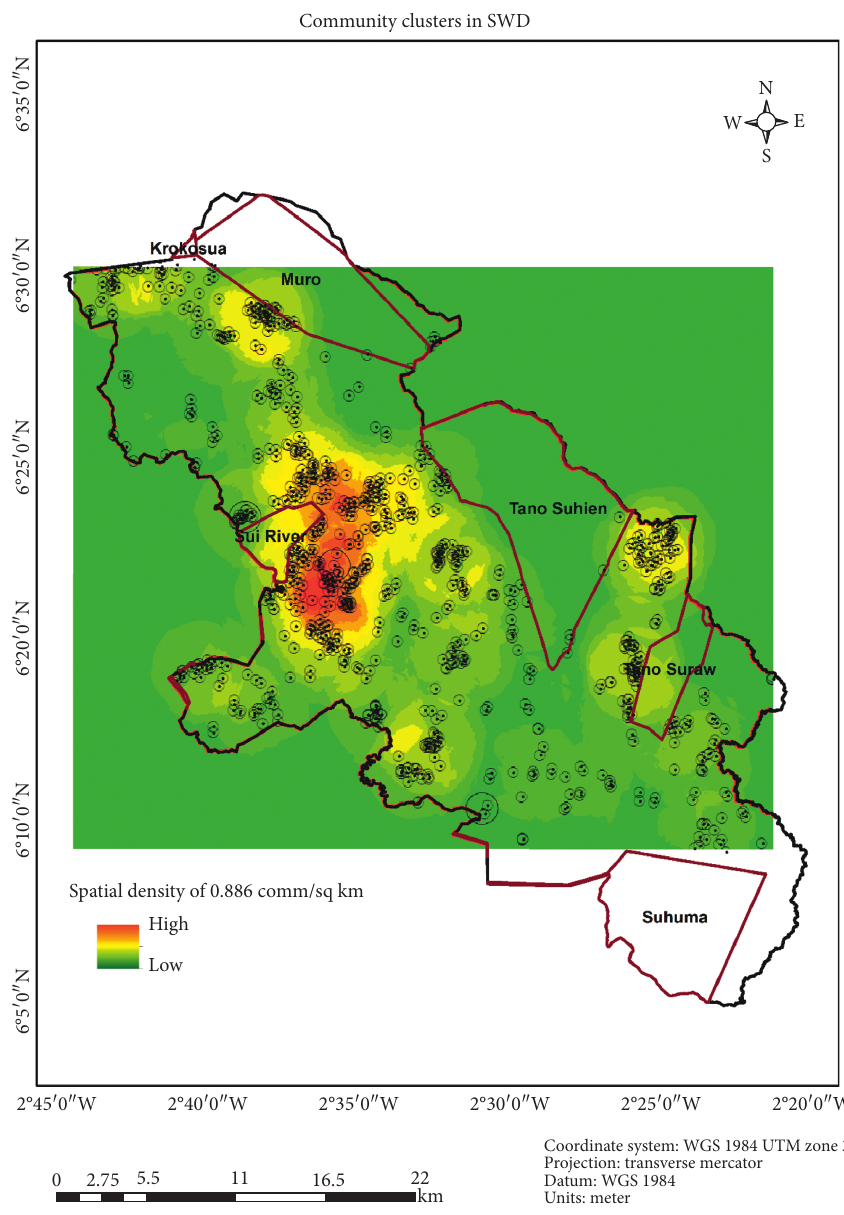
Figure 6: A community density raster created through spatial